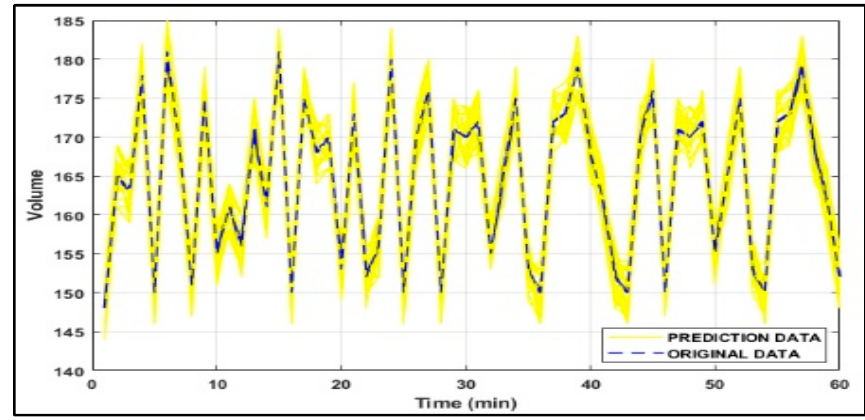
Figure 8. Monte Carlo experiment results over a 60 ‐ min period.